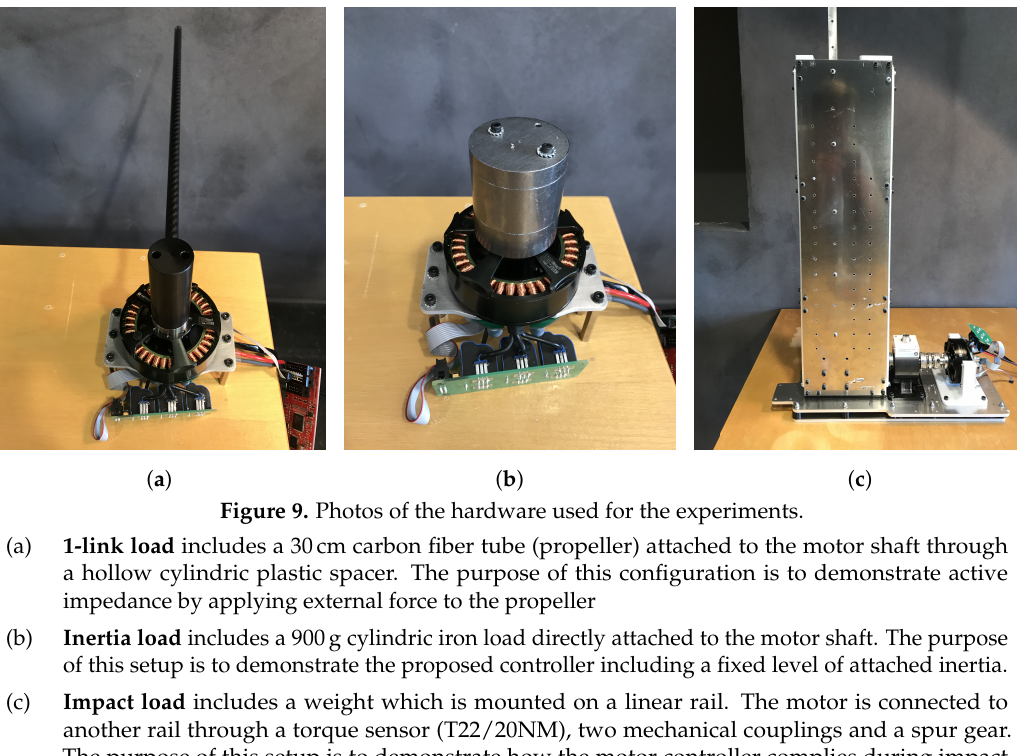
Figure 9. Photos of the hardware used for the